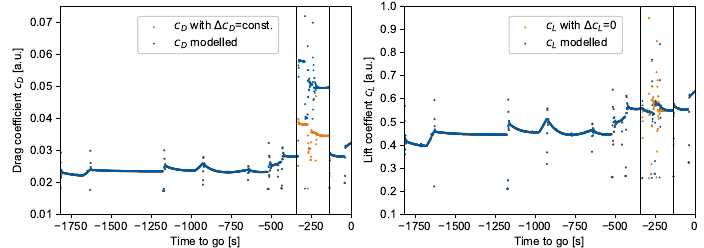
Figure 12. Comparison of drag coefficient ( left ) and lift coefficient ( right ) during the B748F vali- dation flight. Blue: modelled with the aircraft-type-specific speed brake model; orange: assuming ∆ c = 0.02 and ∆ c = 0.00. The aircraft-type-specific speed brake model results in increased drag D L and a slightly decreased lift when speed brakes are deflected. Vertical lines indicate time frame with significantly deflected